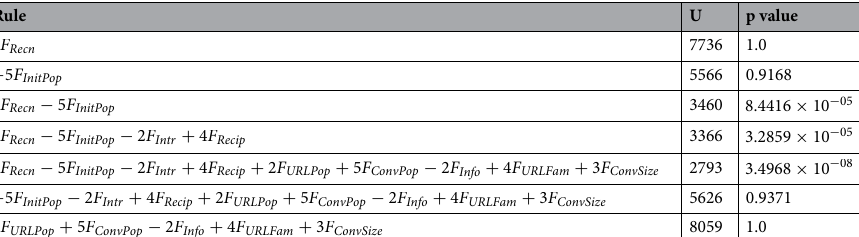
Table 2. Comparisons between prioritization rules derived from evolutionary model discovery insights against a null model. Results for Mann–Whitney U tests for the alternative hypothesis that each derived model had a median RMSE less than that of the null model with random priority allocation (significance level = 0.05). Only models that included both F Recn and F InitPop outperformed the null model.